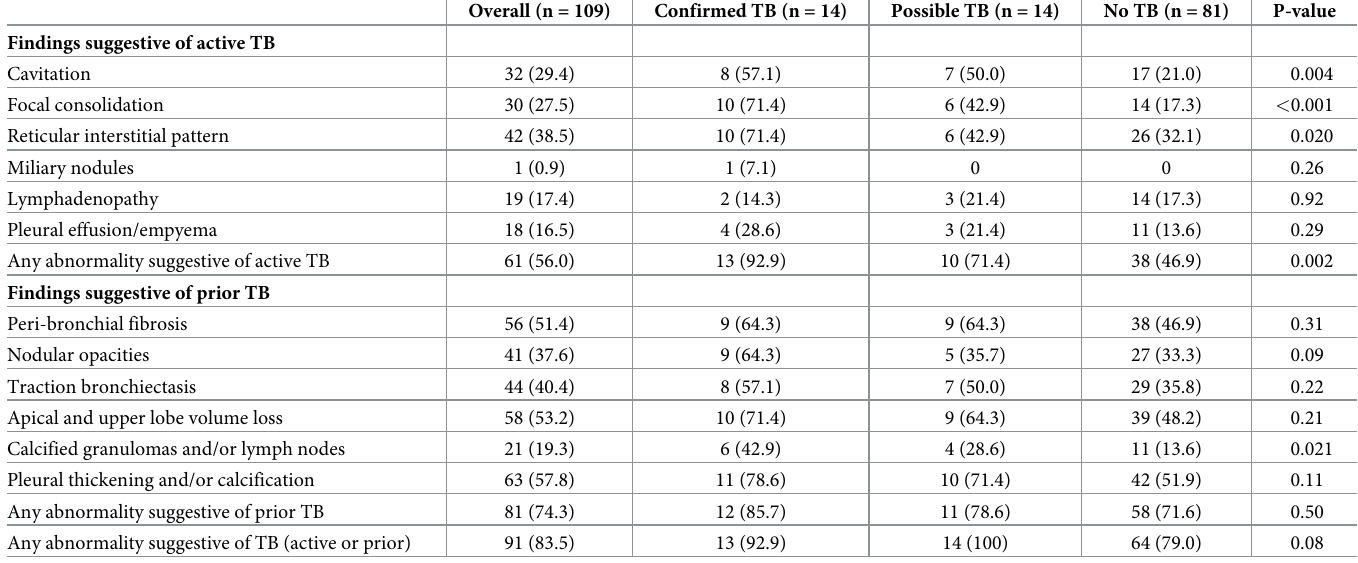
Table 2. Overview of chest radiography characteristics among presumptive TB patients with a prior history of TB, according to their current TB disease classifica- tion (n =